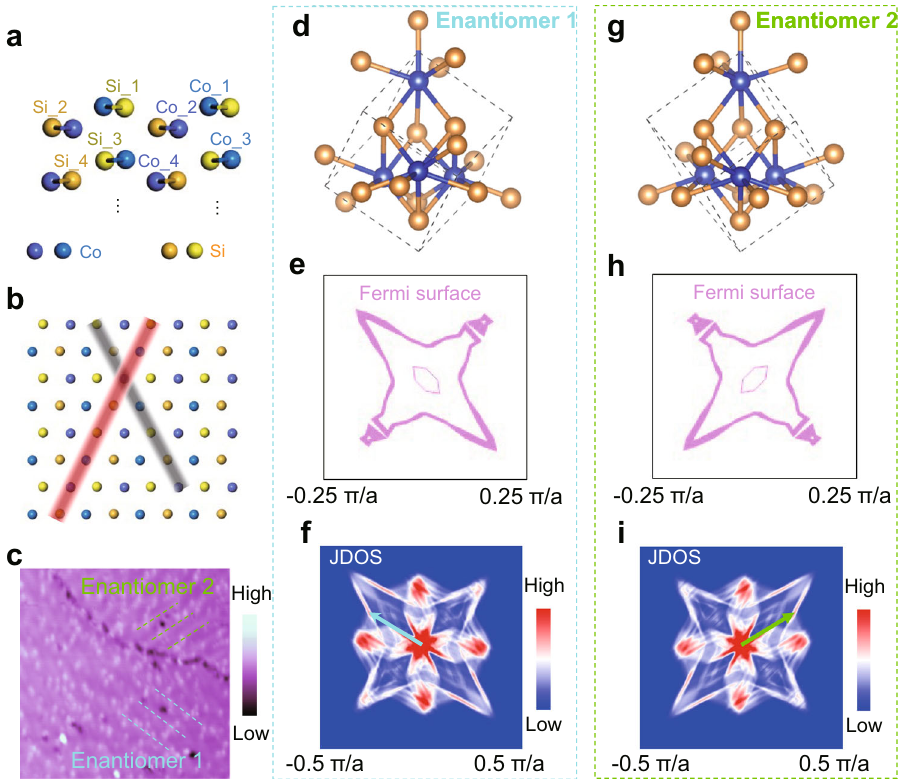
Fig. 4 Origin of chirality-locking, unidirectional CDW in CoSi. a Atomic structure of the four sub-layers in a unit cell of CoSi. b Top view of the fi rst and second sublayers. The red line outlines the electron hopping path of Co_1-Co_2-Si_2-Si_1-Co_1-Co_2 … . The gray line outlines another path following the same atomic sequence in the two-sublayer model. These two paths are inequivalent with each other in bulk CoSi. c Large-scale STM image showing coexistence of two different crystal enantiomers separated by a domain boundary. The blue and green dashed lines highlight the CDW stripes of enantiomers 1 and 2, respectively. The CDW orders are unidirectional in both enantiomers, but their CDW wave vectors point to different directions respectively. Atomic structures of crystal enantiomers 1 ( d ) and 2 ( g ). DFT revealed constant-energy contours of the Fermi surface at the adjusted Fermi level of enantiomers 1 ( e ) and 2 ( h ). These contours are only distributed around the Г point in the k -space and the CDW was observed on the x-y plane of the crystal, thus, a slab at k z = 0 with a range of ±0.25 π /a was plotted. Derived JDOS plots, with numerically enhanced contrast, of the DFT Fermi surface contours of enantiomers 1 ( f ) and 2 ( i ). The blue ( f ) and green ( i ) arrows mark the experimentally observed CDW wave vectors in both direction and amplitude for enantiomers 1 and 2, respectively. The atomic structures, energy contours and JDOS of the two enantiomers show mirror symmetry with each